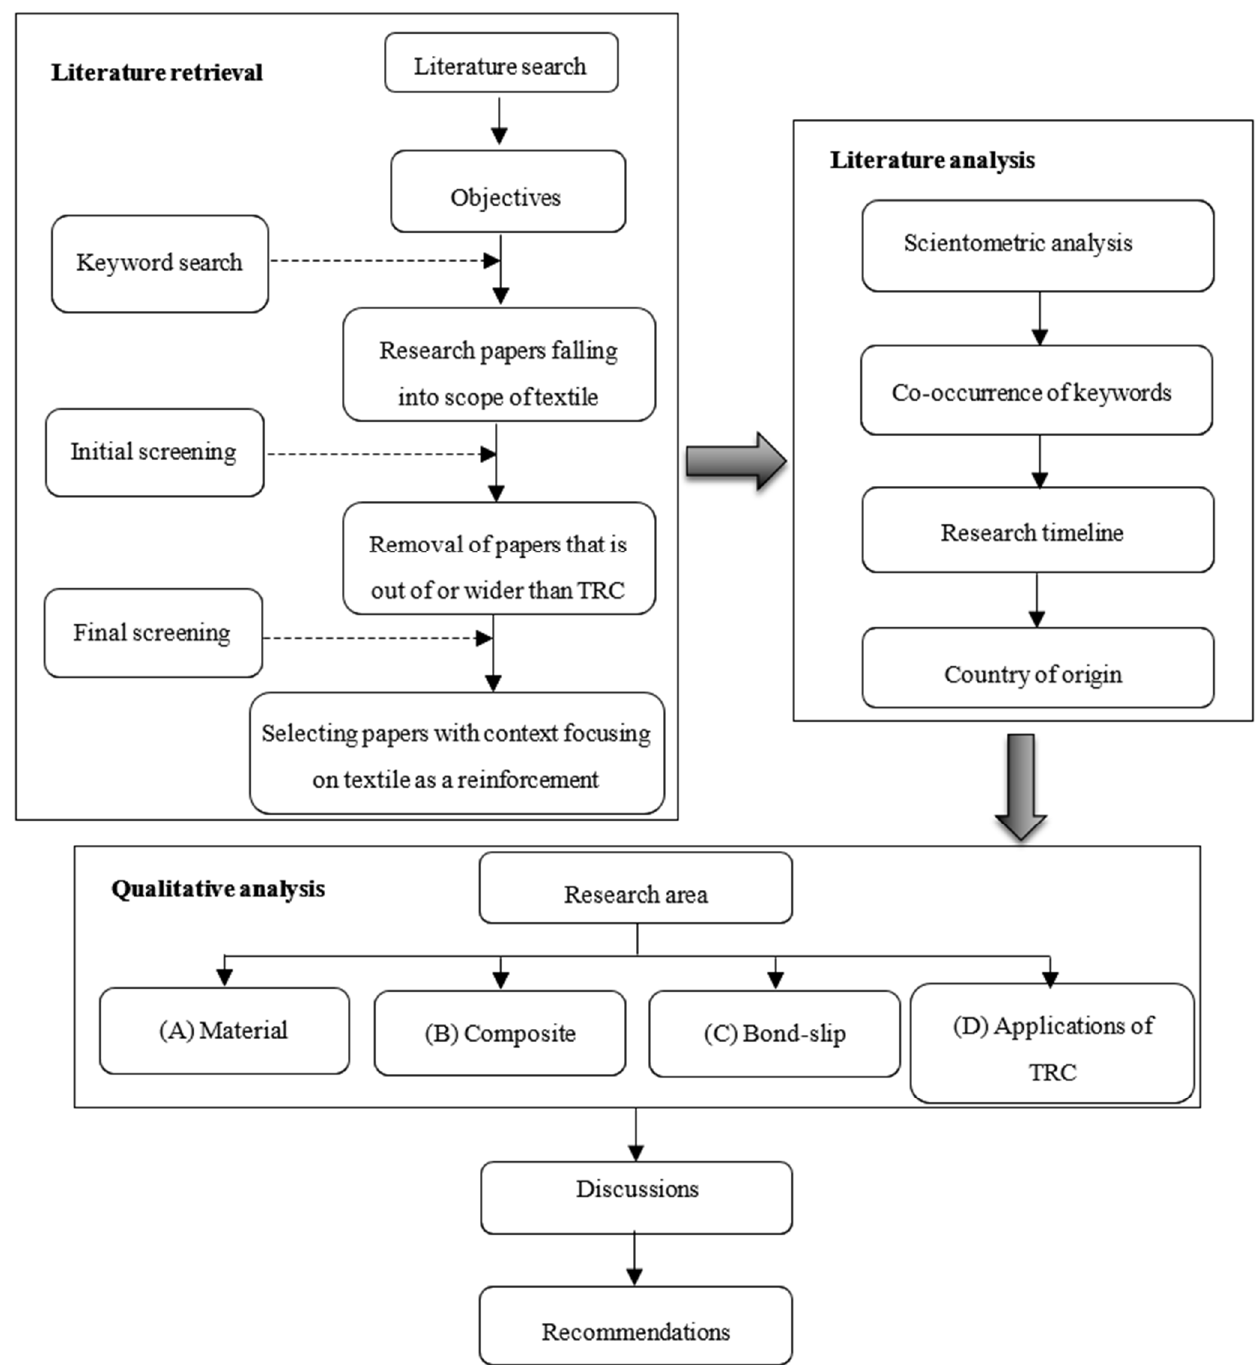
Figure 1. Workflow for reviewing the literature on TRC.